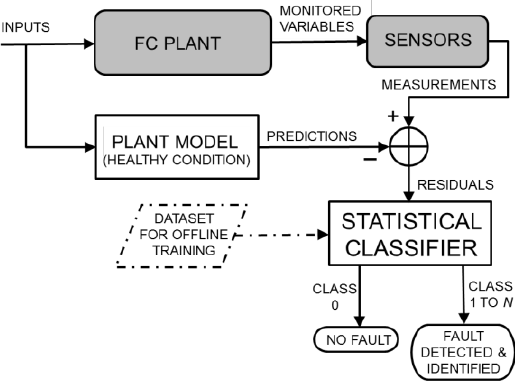
Figure 3. Schematic of the hybrid FDI strategy for FC plants, where residuals generated by the parity equations are processed by an adequately trained statistical classifier.